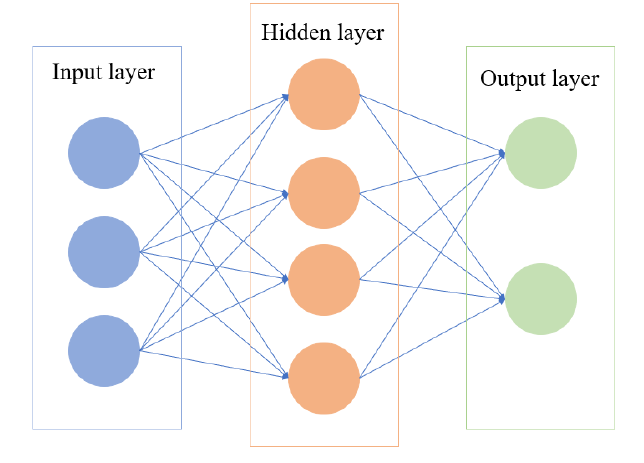
Figure 9. Diagram of a three-layer neural